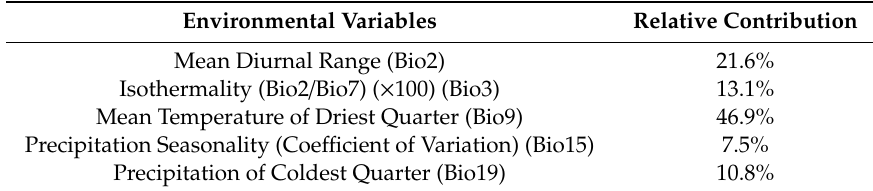
Table 1. Relative contribution of each environmental variables to the MaxEnt